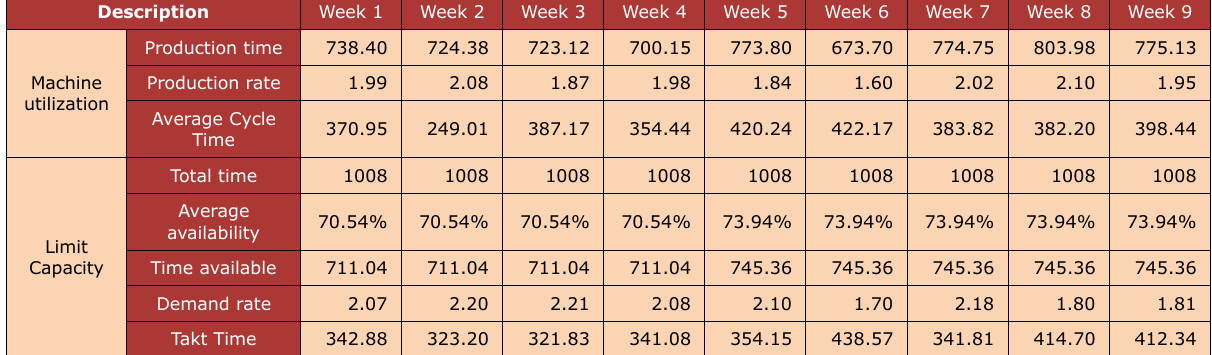
Table 1. Average cycle time and Takt time of six Autoclaves in nine